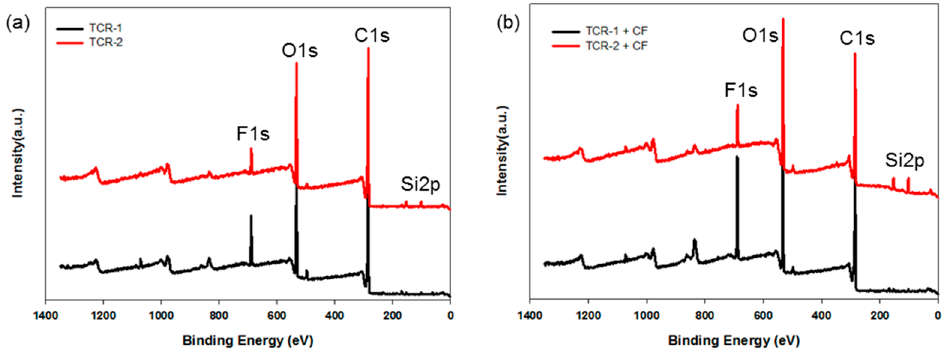
Figure 9. XPS survey spectra of the ( a ) TCR-1, TCR-2, ( b ) TCR + CF nanocomposites (TCR-1 + CF, TCR-2 + CF).